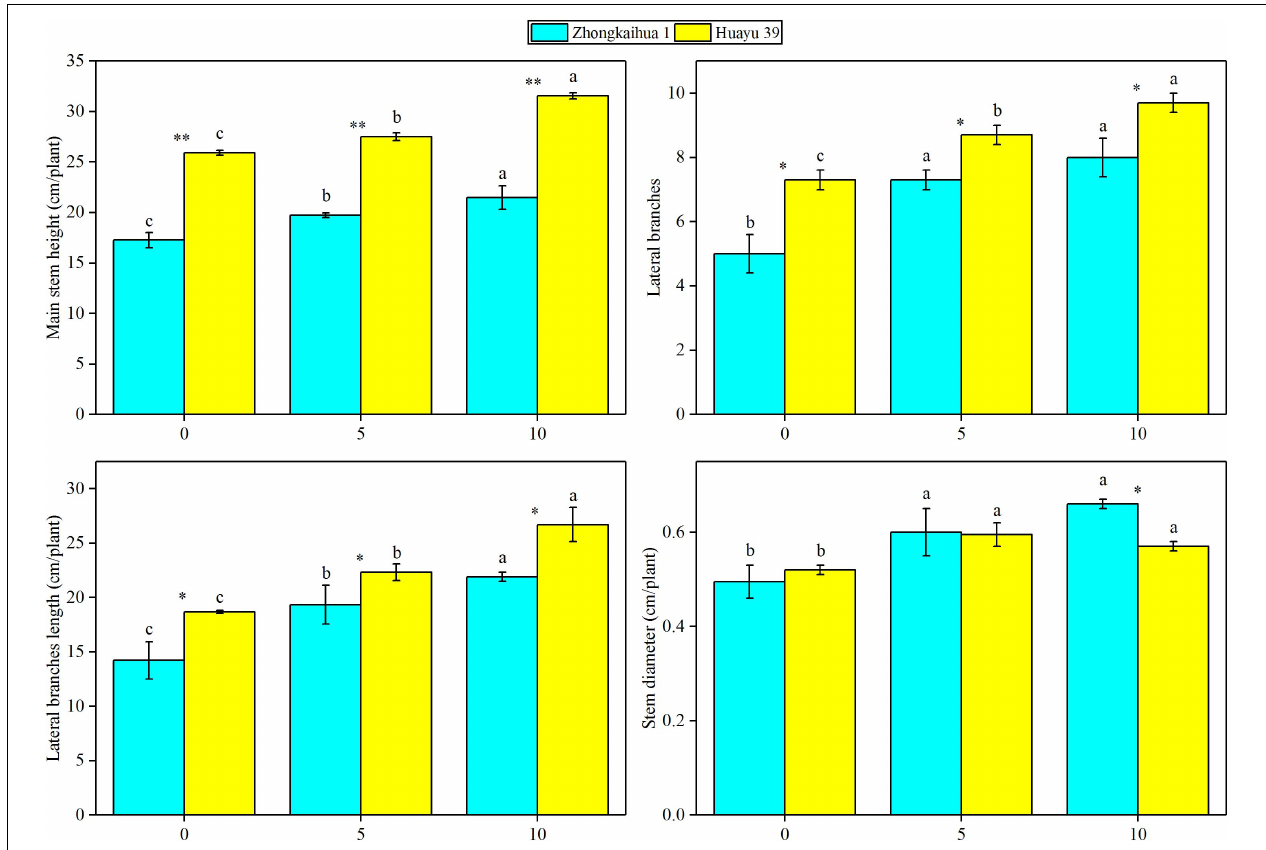
FIGURE 9 | Effects of waterlogging stress on the morphology of peanut plant. Data represent the mean ± standard error. Letters a and b after the value represent statistically significant differences ( p < 0.05) within a variety under different waterlogging treatments as determined by the least significant difference test. Significant differences at * p < 0.05 and ** p < 0.01 between Zhongkaihua 1 (ZKH 1) and Huayu 39 (HY 39) under the same treatment.